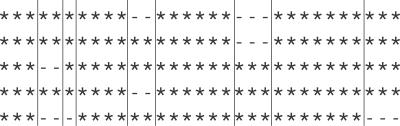
Alignment PriorFor calculating the gap contribution to the prior, F
3(A), we decompose the alignment into homogeneous groups based only on the pattern of the gaps in the alignment. Each asterisk represents a nucleotide in the alignment, and each dash denotes a gap in the alignment.